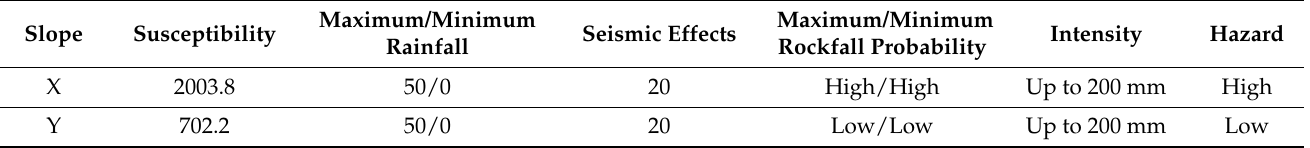
Table 13. Rockfall susceptibility, probability and hazard of Slope X and Slope Y according to the proposed